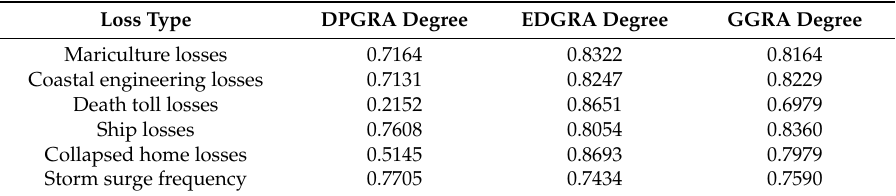
Table 2. Estimated relational degrees from the proposed DPGRA model and two conventional GRA models.